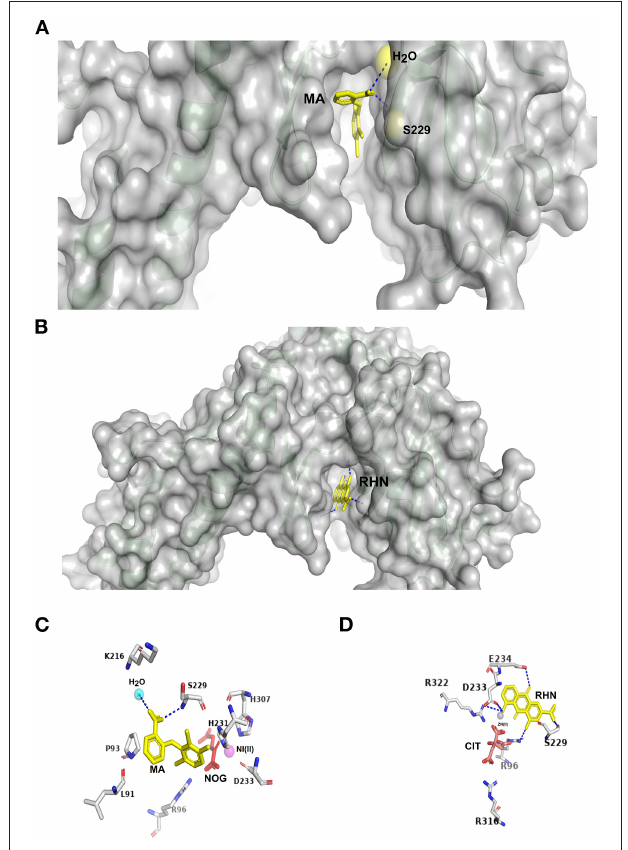
FIGURE 3 | Specific recognition of inhibitors within FTO. (A) Meclofenamic acid (MA) binds to the deep pocket on the surface of FTO (PDB ID: 4QKN) (represented by gray semitransparent surface); MA represented by yellow residue binds to both H 2 O yellow circle and S229 yellow residue by blue covalent bonds. (B) Rhein RHN binds to the deep pocket on the surface of FTO (PDB ID: 4IE7) (represented by gray semitransparent surface); RHN is represented by yellow residue binds to the active site residues by blue covalent bonds. (C) Detailed view of meclofenamic acid (MA) within FTO (PDB ID: 4QKN) active residues (gray carbon residues identified by their numbers); MA is represented by yellow color residue, attached to the active site residues by blue covalent bonds; 2-oxoglutarate analog (NOG) is represented by red carbon residues; nickel (Ni) atom is represented by a pink circle. H 2 O is represented by a pink circle. (D) Detailed view of Rhein (RHN) within FTO (PDB ID: 4IE7) active residues (gray carbon residues identified by their numbers); RHN is represented by yellow color residue, attached by active site residues by blue covalent bonds; citrate molecule (CIT) is represented by red residue; zinc (Zn) atom is represented by a dark gray